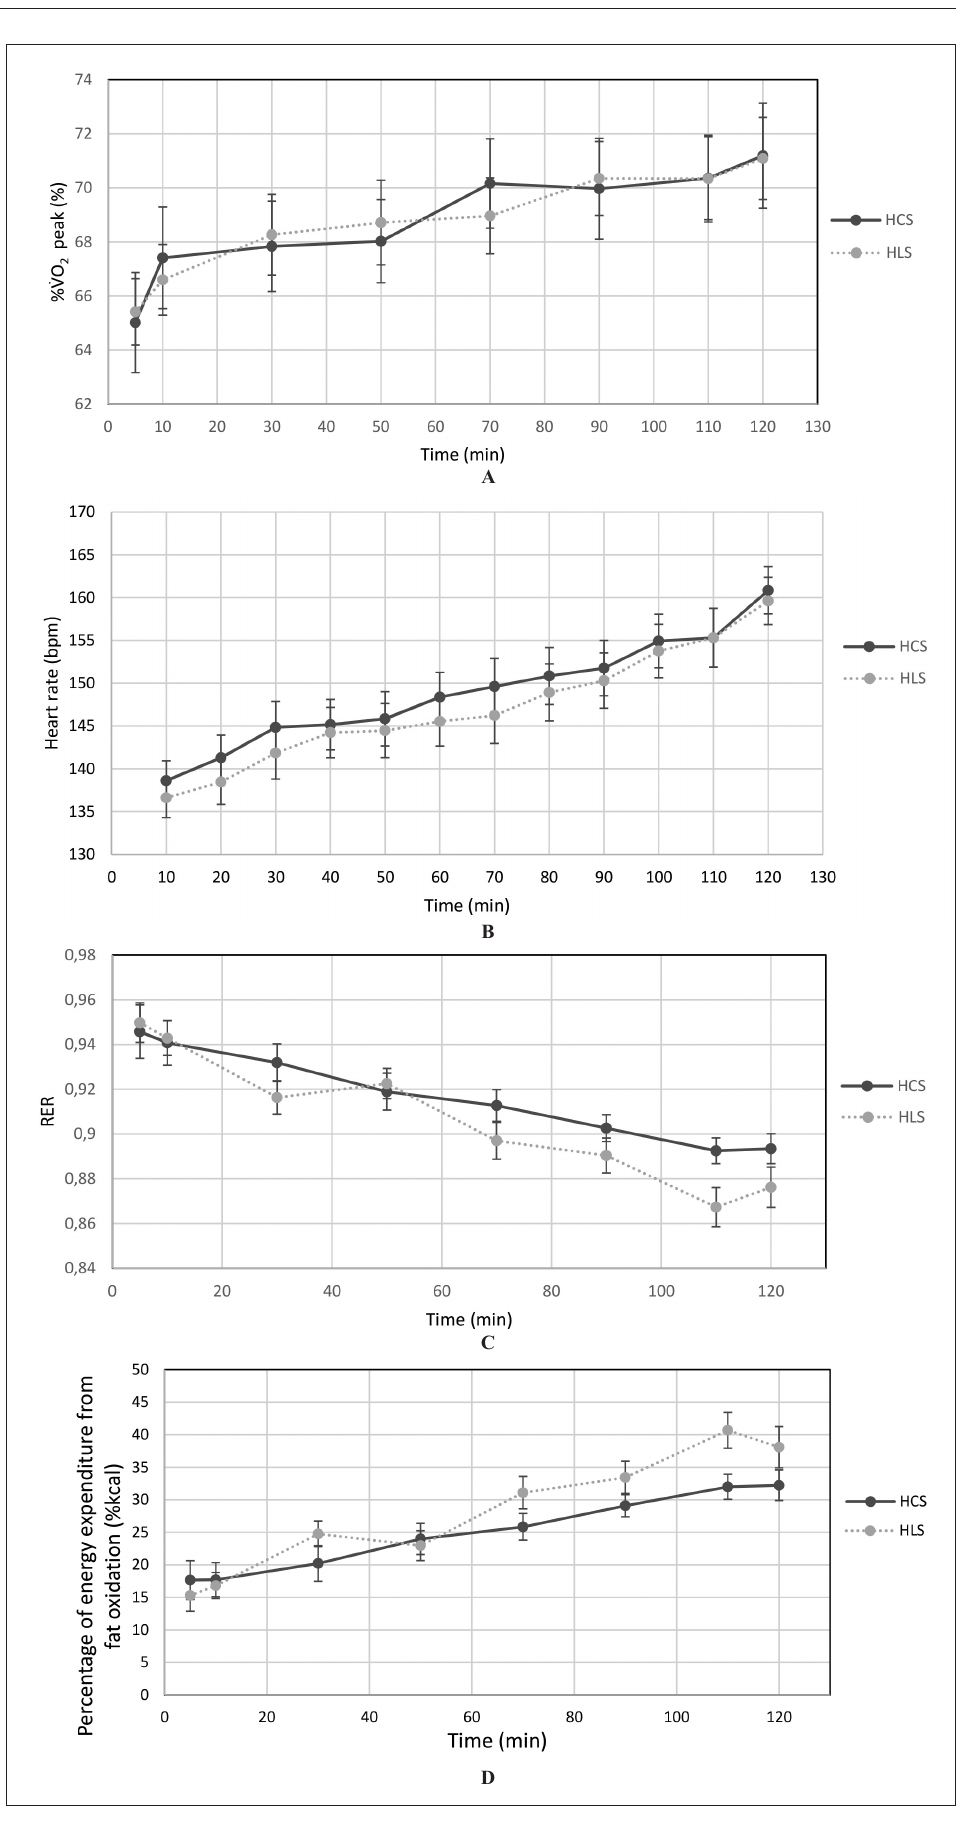
Figure 1. (A), Percent- age of maximal oxy- gen consumption, (B), heart rate, (C) RER and (D), percentage of energy expenditure from fat oxidation during the 2 h at 65 % of MAP when consum- ing either carbohy- drates or